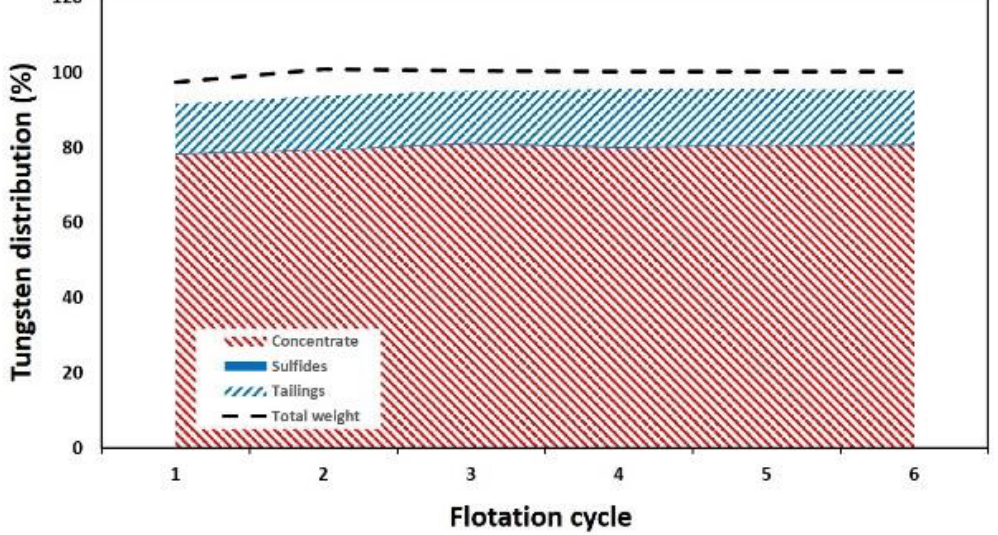
Figure 10. Mass and tungsten (W) output distribution of each cycle product by locked cycle test, respectively . Table 2. Concentrate grade, enrichment ratio (ER), recovery and yield of each cycle product of locked cycle test.